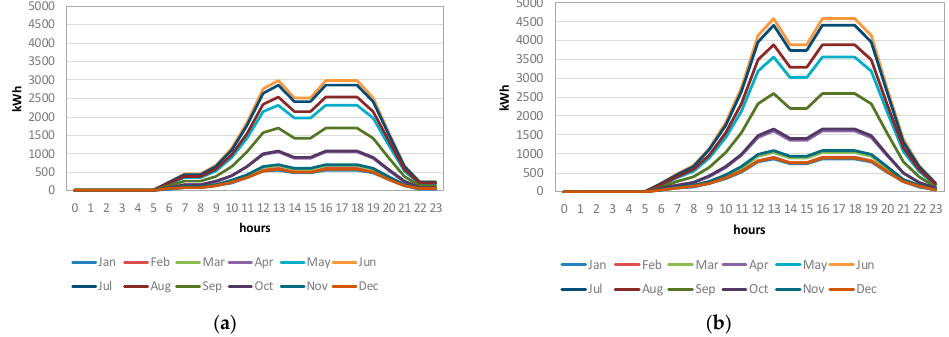
Figure 3. Hourly thermal cooling demands (kWh t ) of the commercial center throughout the year: ( a ) working days; ( b ) holidays.